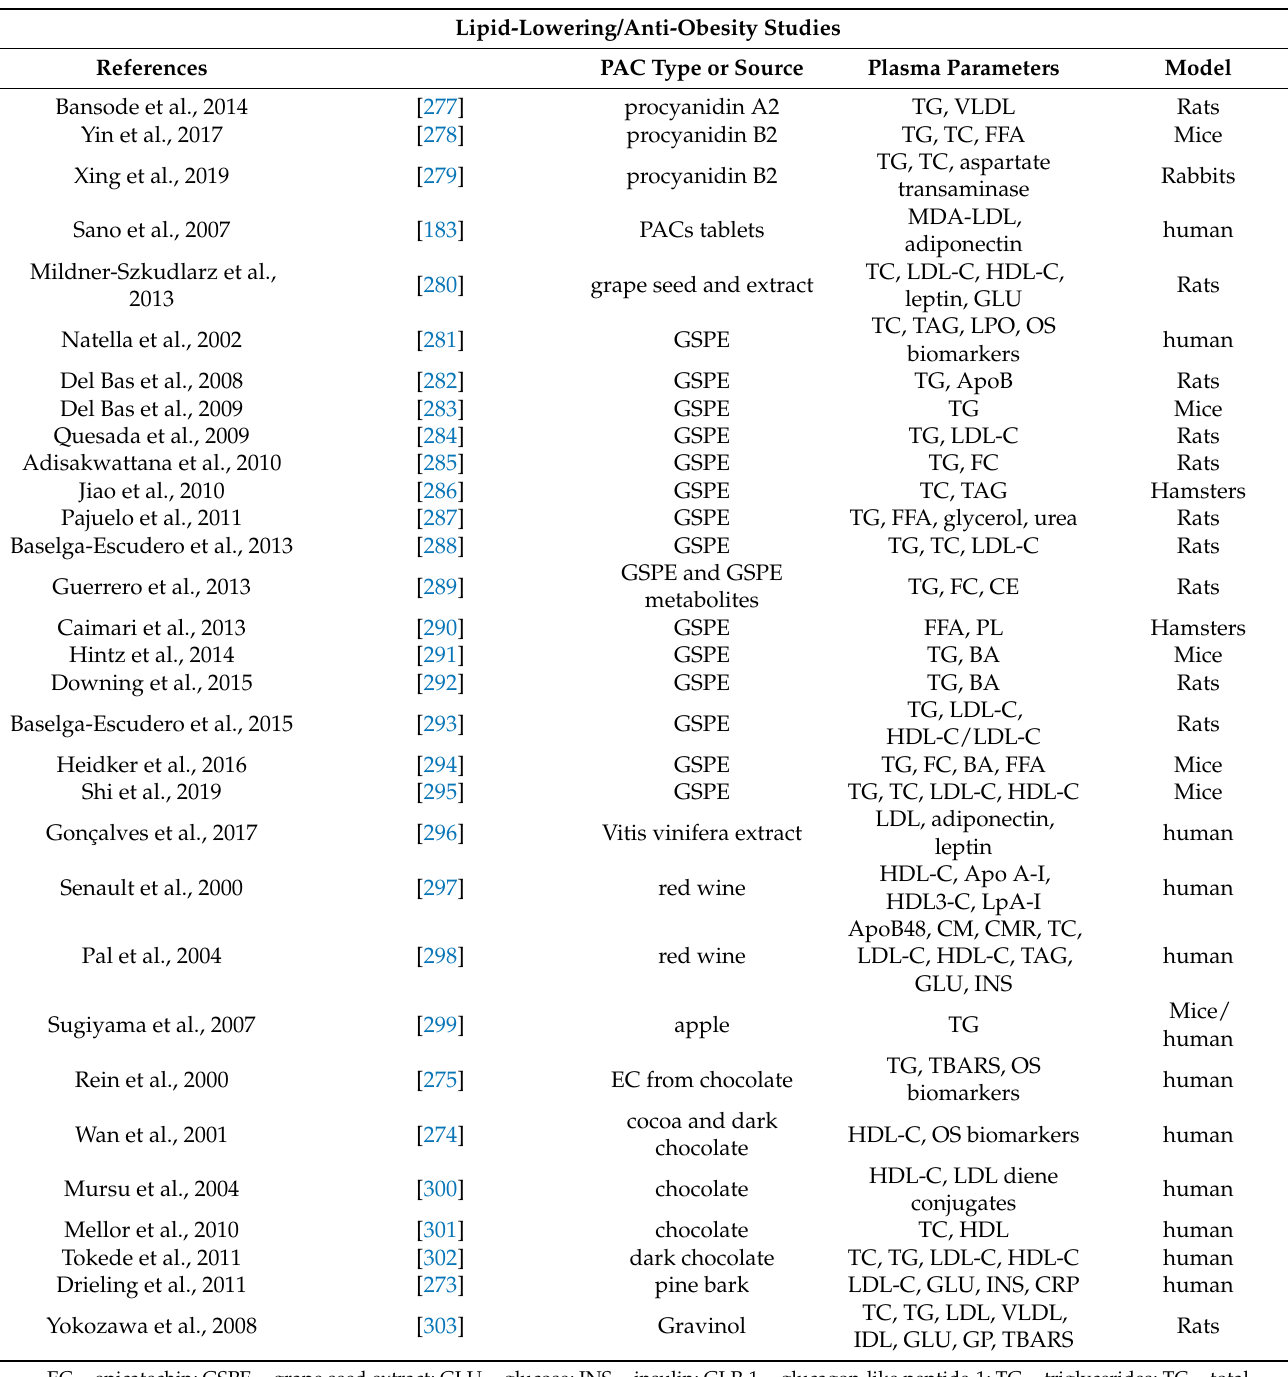
Table 3. In vitro and in vivo studies on PAC-mediated and lipid-lowering